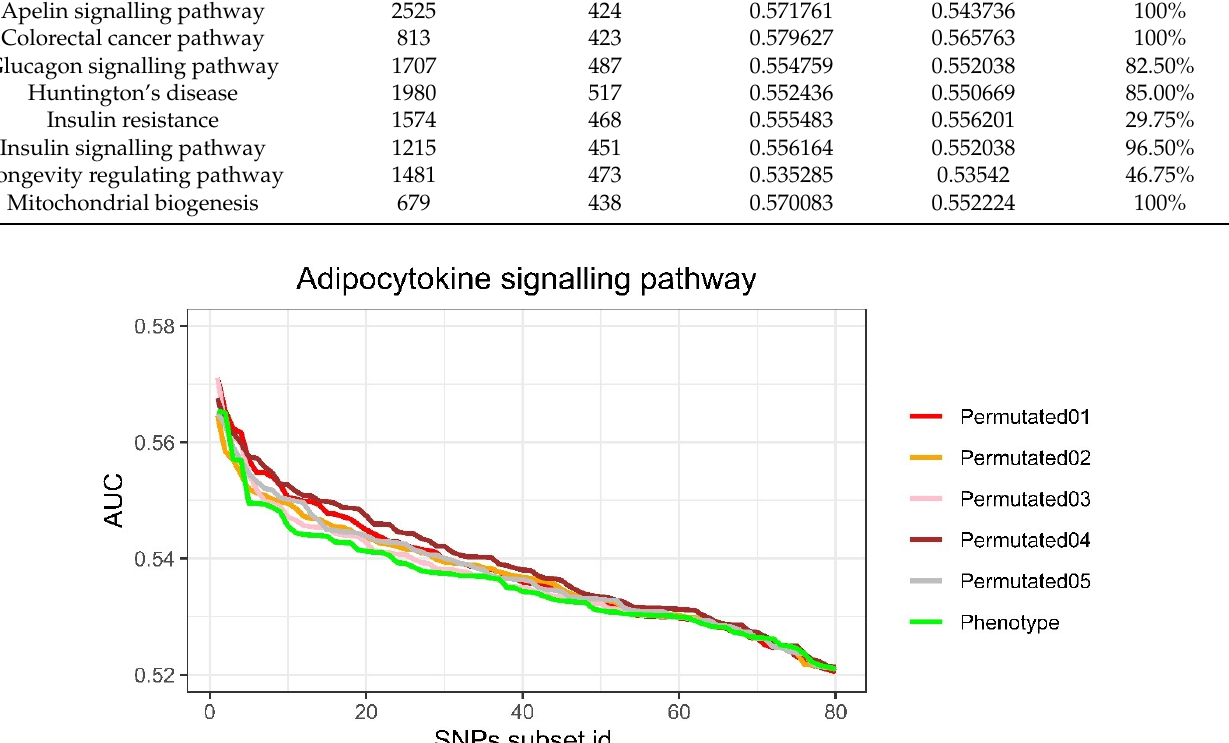
Figure 3. AUC values of the 80 iterations performed for the adipocytokine signaling pathway in the case of cases and controls (phenotype) and five different permutations.